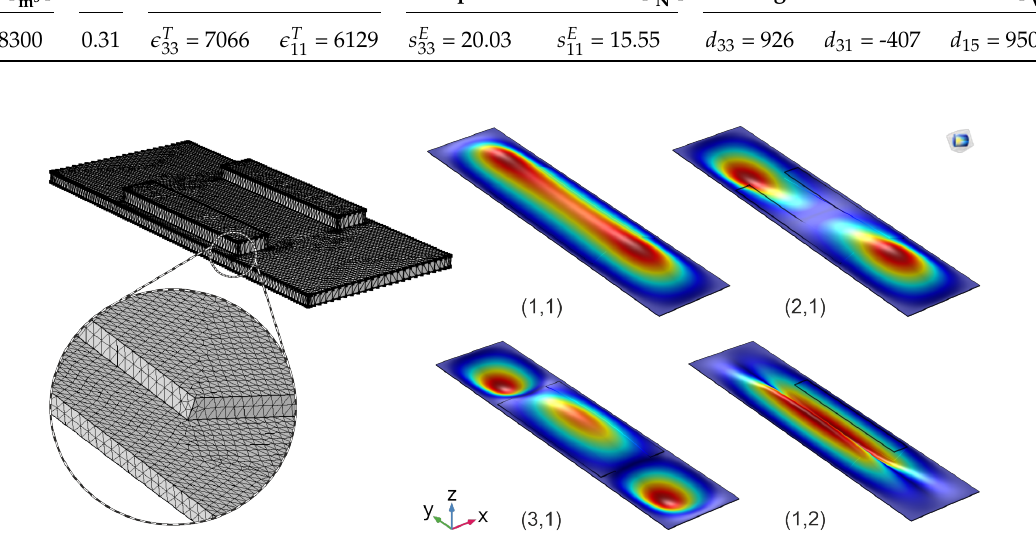
Figure 2. COMSOL Multiphysics implementation of the design with a tetrahedral element mesh and the expected vibration modes of the